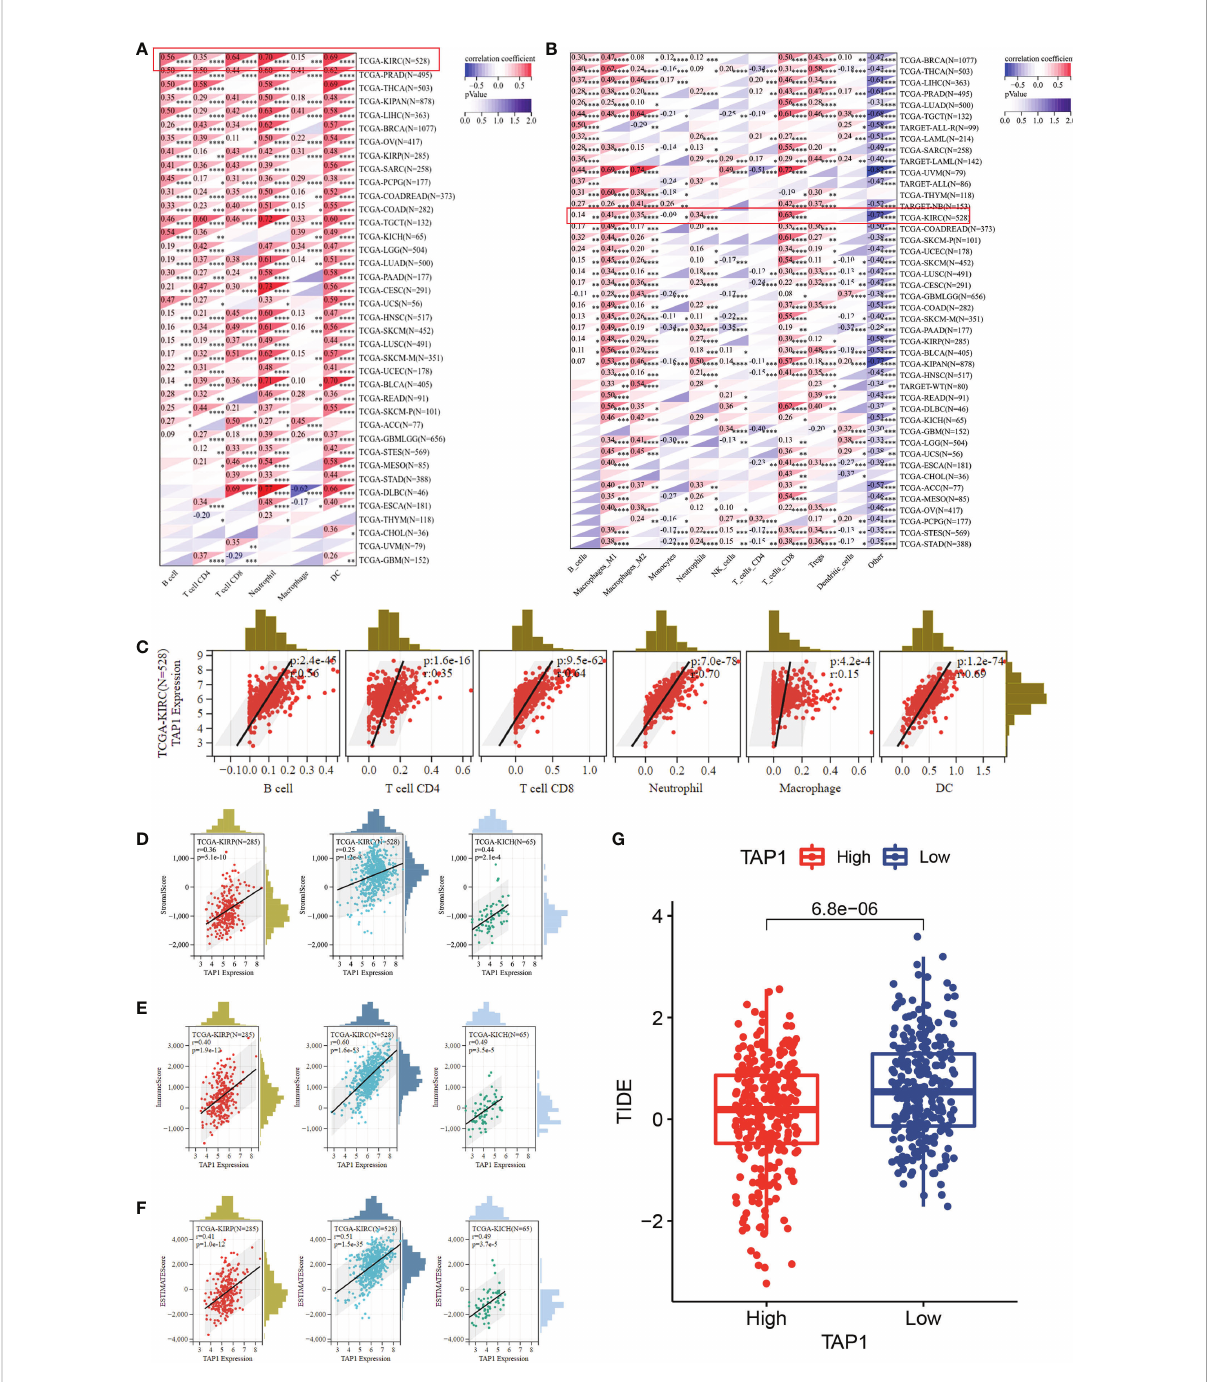
FIGURE 4 TAP1 expression is positively correlated with immune cell in fi ltration via multiple algorithms. (A) The landscape of TAP1 correlating with various immune in fi ltrates in pan-cancer with The tumor immune estimation resource (TIMER). (B) The landscape of TAP1 correlating with various immune in fi ltrates in pan-cancer with QUANTISEQ. (C) Scatter plot showed relationship between immune cells and TAP1 expression in KIRC, including B cells (cor. = 0.56), CD4+ T cells (cor. = 0.35), CD8+ T cells (cor. = 0.64), Neutrophil (cor. = 0.70), Macrophage (cor. = 0.15), dendritic cell (DC) (cor. = 0.69). (D-F) Immune in fi ltration score of TAP1 in KIRC, Kidney renal papillary cell carcinoma (KIRP), Kidney Chromophobe (KICH). D , Stromal Score, E , Immune Score, F, ESTIMATE Score. (G) High level of TAP1 expression indicates better immune checkpoint inhibitor response based on Tumor Immune Dysfunction and Exclusion (TIDE) (p < 0.0001). *, P < 0.05; **, P < 0.01; ***, P < 0.001; ****, P <